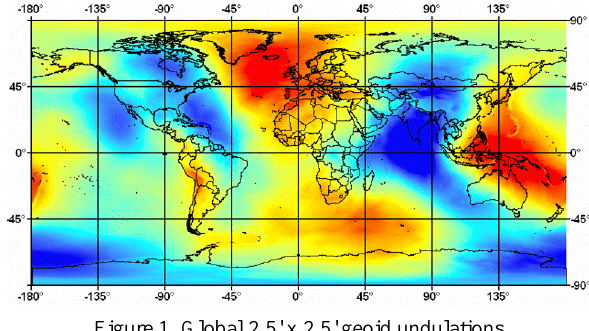
Figure 1. Global 2.5' x 2.5' geoid undulations